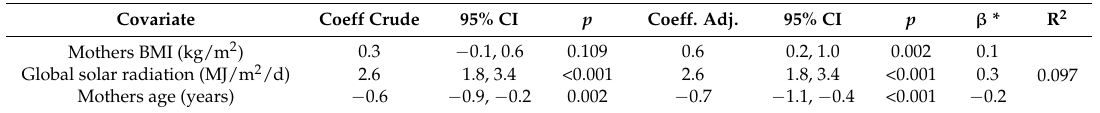
Table 5. Predictors for plasma 25(OH)D (nmol/L) concentrations in a random sample of Nepalese lactating women. Covariate Coeff Crude 95% CI p Coeff. Adj. Mothers BMI (kg/m 2 )